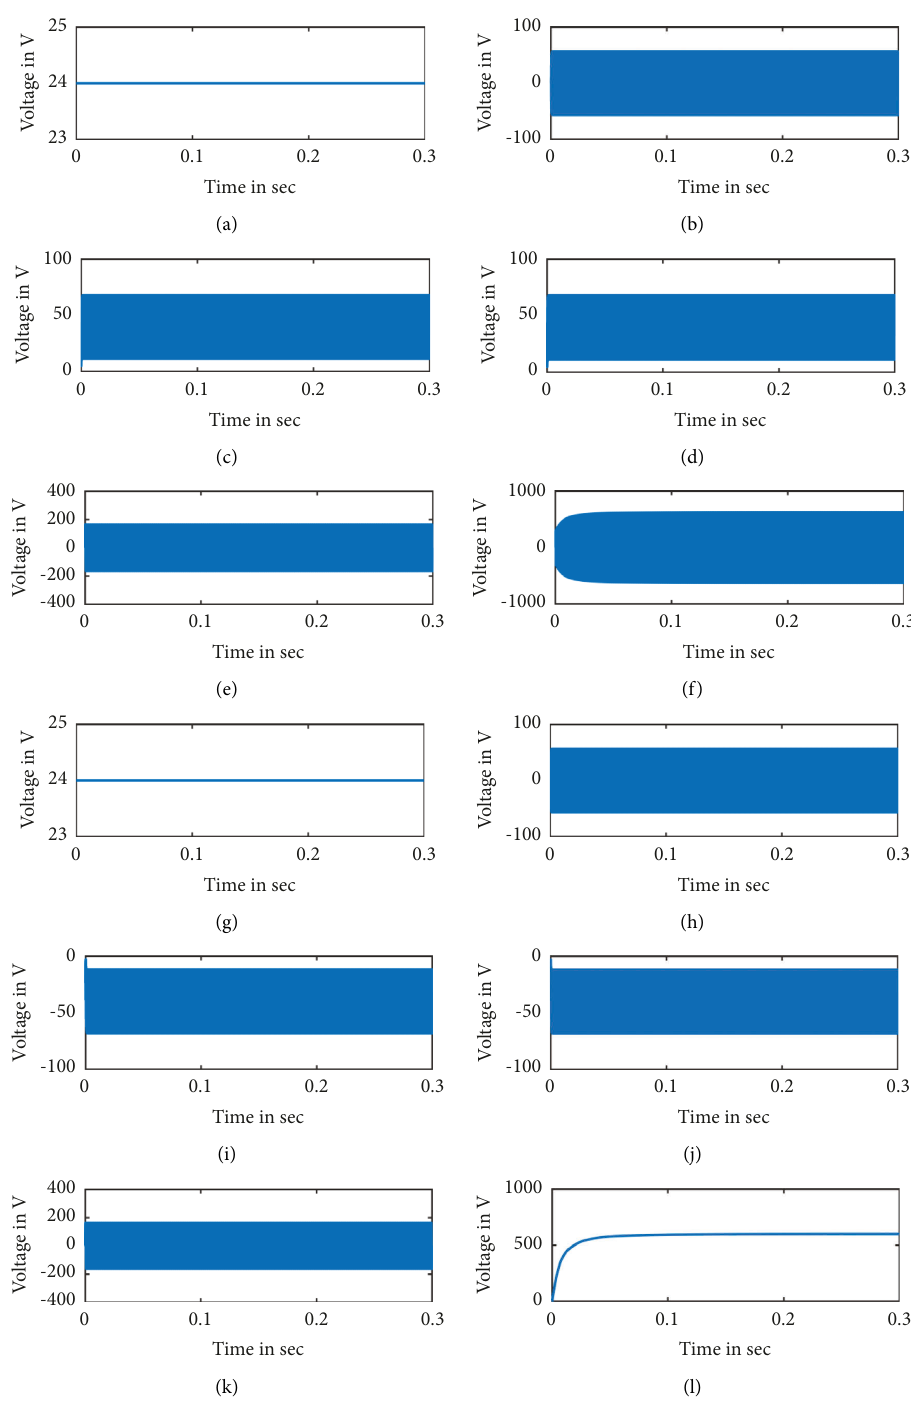
Figure 14: Simulation results of the proposed MMPIFC boost converter for investigation 1. (a) PV array 1 voltage. (b) Voltage across the input inductor L A . (c) Voltage across the capacitor C A1 . (d) Voltage across the capacitor C A2 . (e) Primary 1 voltage HF transformer. (f) Secondary voltage of HF transformer. (g) PV array 2 voltage. (h) Voltage across the input inductor L B . (i) Voltage across the capacitor C B1 . (j) Voltage across the capacitor C B2 . (k) Primary 2 voltage HF transformer. (l) DC bus